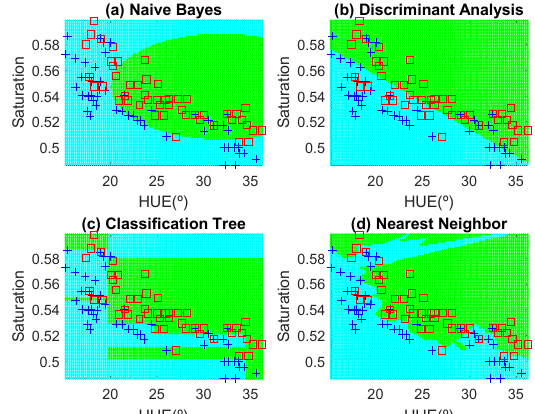
Figure 14. Decision boundaries and scatter plot (class 1 squares, class 2, crosses) for the red apple. ( a ) Naive Bayes, ( b ) linear discriminant analysis, ( c ) classification tree and ( d ) Nearest Neighbor (k = 5).